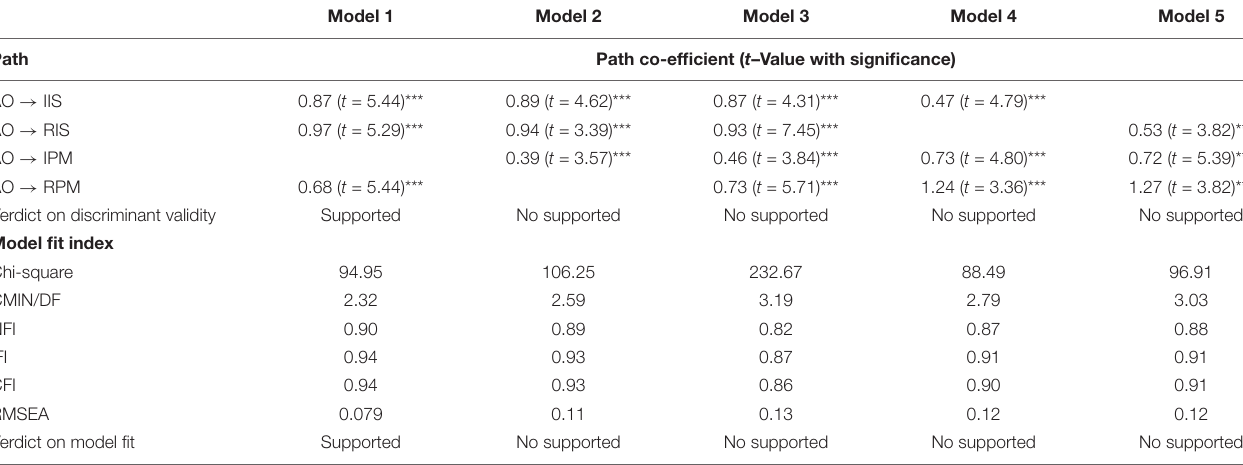
TABLE 3 | Results of AO integrated as a second-order